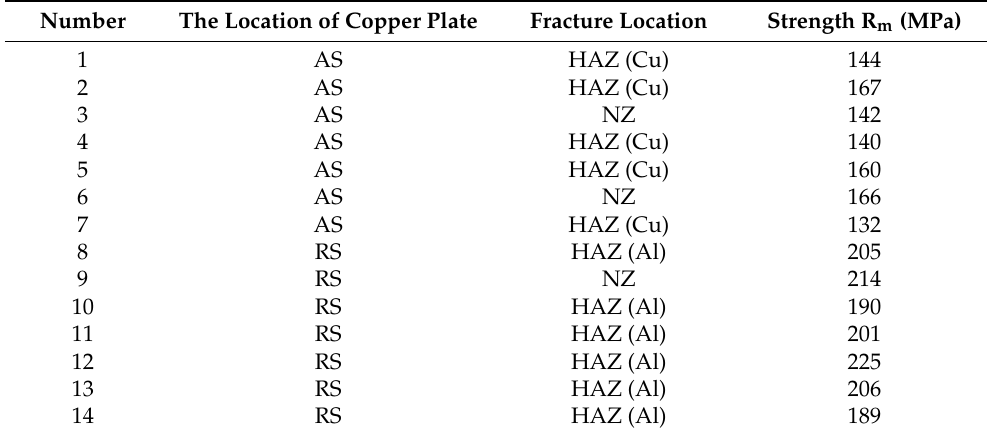
Table 5. Tensile strength of a dissimilar Al/Cu joint according to the different parameters of welds (from reference [36]).